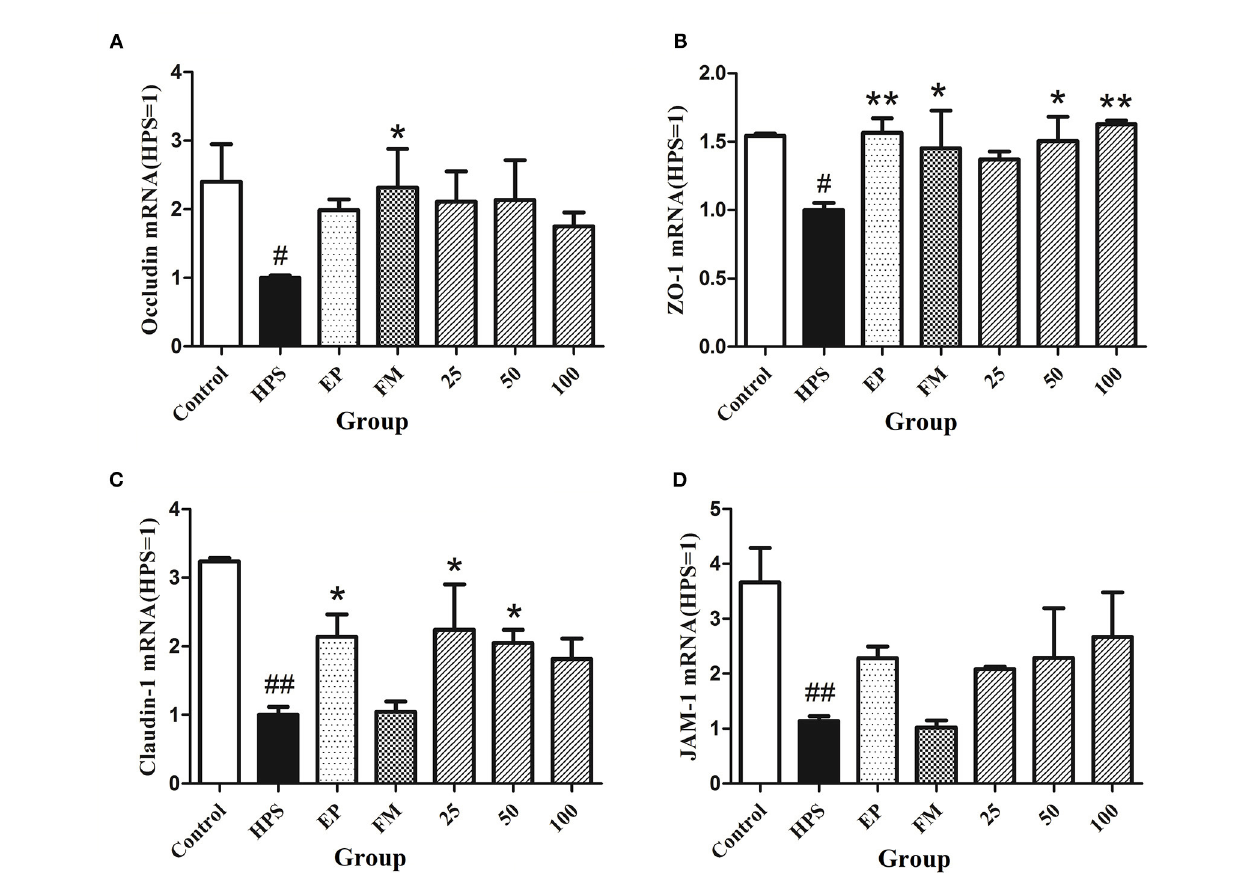
FIGURE 1 | Effects of baicalin on expression of TJ genes occludin (A) , ZO-1 (B) , claudin-1 (C) , and JAM-1 (D) in aorta of piglets challenged with G. parasuis (mean ± SD, n = 3). HPS: G. parasuis group, EP: EP + G. parasuis group, FM: FM + G. parasuis group, 25: 25 mg/kg baicalin + G. parasuis group, 50: 50 mg/kg baicalin + G. parasuis group, 100: 100 mg/kg baicalin + G. parasuis group. # p < 0.05 vs. control, ## p < 0.01 vs. control, * p < 0.05 vs. G. parasuis group, ** p < 0.01 vs. G. parasuis